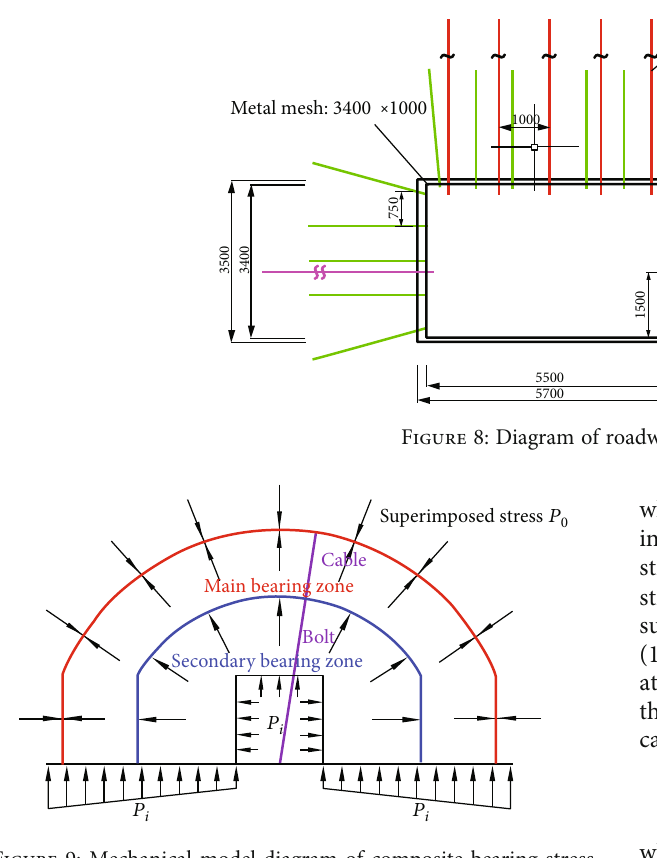
Figure 9: Mechanical model diagram of composite bearing stress arch